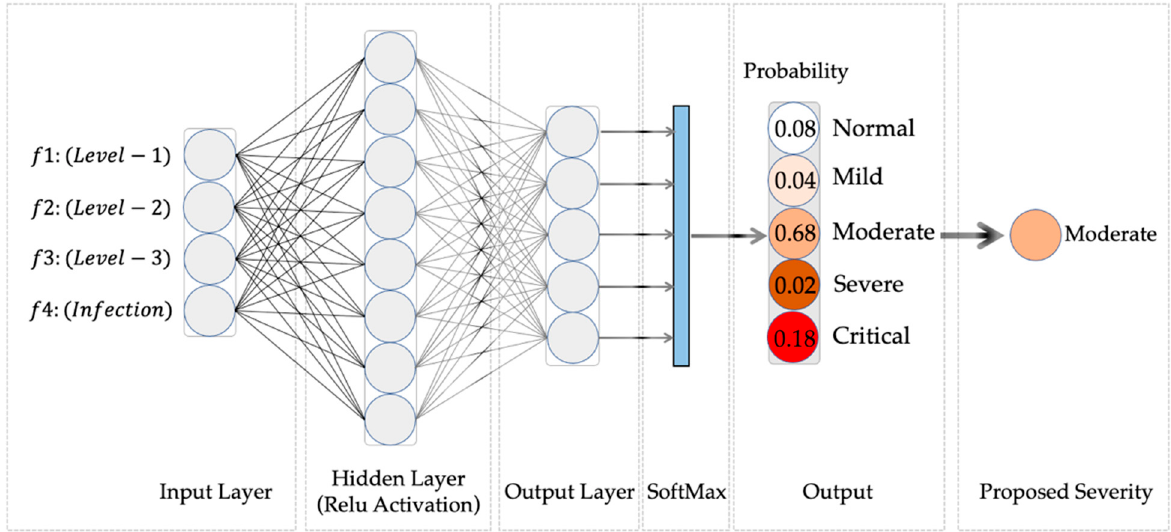
Figure 4. Structure of the multi-layer preceptor network (g = 3). 𝑓 (cid:2869)(cid:2879)(cid:2872) denotes the input features of the MLP network. 𝑓 (cid:2869)(cid:2879)(cid:2871) denotes the proportion of infected pixels of three levels in all infected pixels. 𝑓 (cid:2872) denotes the proportion of infected pixels in lung parenchyma